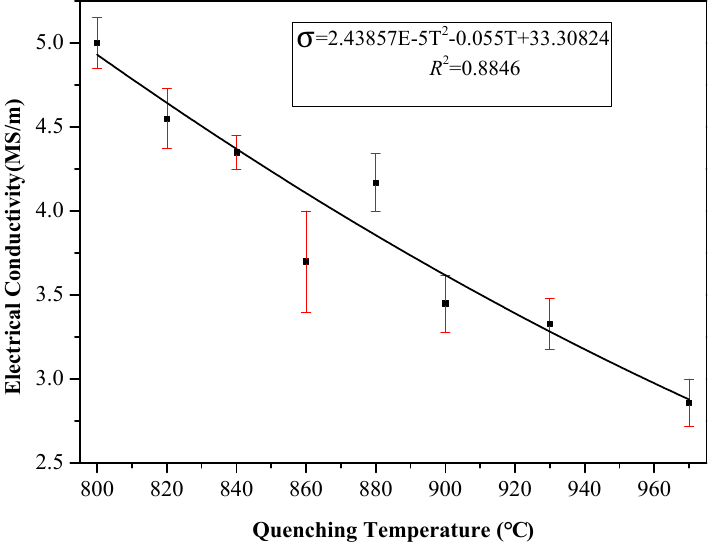
Figure 4. Variation in electrical conductivity with increased quenching temperature.